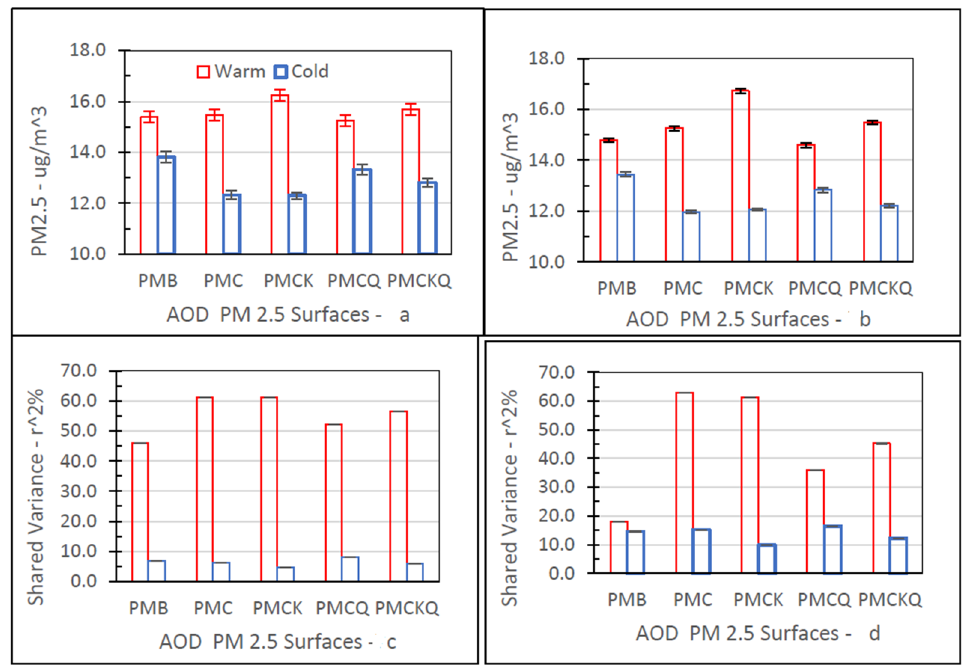
Figure 7. Warm–cold season differences for PM 2.5 concentration ( µ g/m 3 ; top: ( a , b )) and shared variance percent between PM 2.5 and temperature ( r 2% ; bottom: ( c , d )), in grids with (left: ( a , c )) and without (right: ( b , d )) ambient air monitors.